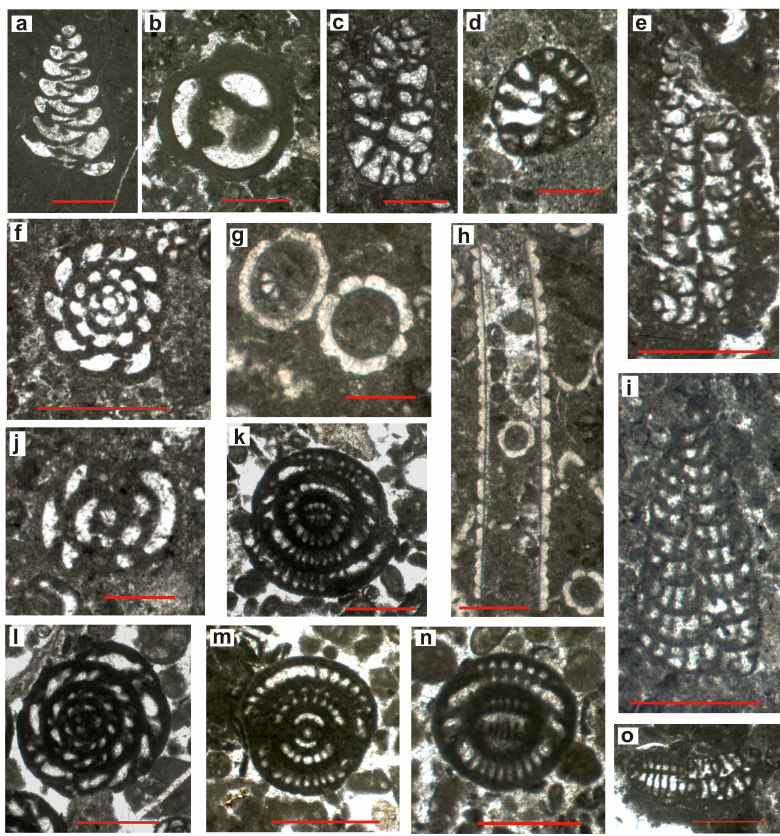
Fig. 4. (a) Praechrysalidina infracretacea , axial section (Mt. Croce, sample CR 70.5); (b) Praechrysalidina infracretacea , transversal section (Mt. Croce, CR 55.4); (c) Voloshinoides murgensis , sub-axial section (Mt. Coccovello, CO 1.8); (d) Voloshinoides murgensis , sub-transversal section (Mt. Motola, MO 89.7); (e) Cuneolina parva , axial section (Mt. Motola, MO 137.7); (f) Debarina hahounerensis , equatorial section (Mt. Coccovello, CV 79.2a); (g) Salpingoporella dinarica , transversal section (Mt. Motola, MO 103.8); (h) Salpingoporella dinarica , axial section (Mt. Motola, MO 103.8); (i) Cuneolina parva , axial section (Mt. Motola, MO 137.7); (j) Debarina hahounerensis , sub-axial section (Mt. Coccovello, CV 79.2a); (k) Archaeoalveolina reicheli , sub-axial section (Mt. Coccovello, CO 30.2); (l) Archaeoalveolina reicheli , equatorial section (Mt. Coccovello, CO 30.2); (m) Archaeoalveolina reicheli , axial section (Mt. Coccovello, CO 30.2); (n) Archaeoalveolina reicheli , tangential section (Mt. Coccovello, CO 30.2); (o) Cuneolina parva , sub-transversal section (Mt. Motola, MO 137.7). Scale bar is 500 microns for all